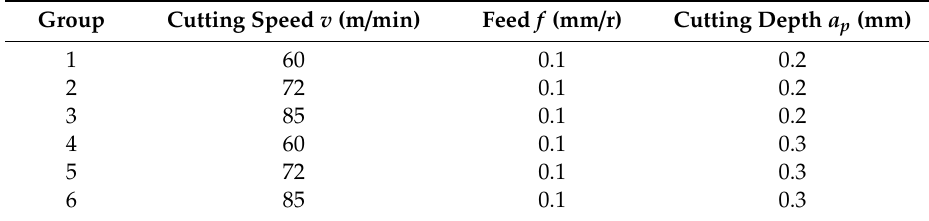
Table 1. Cutting parameters of experiments.